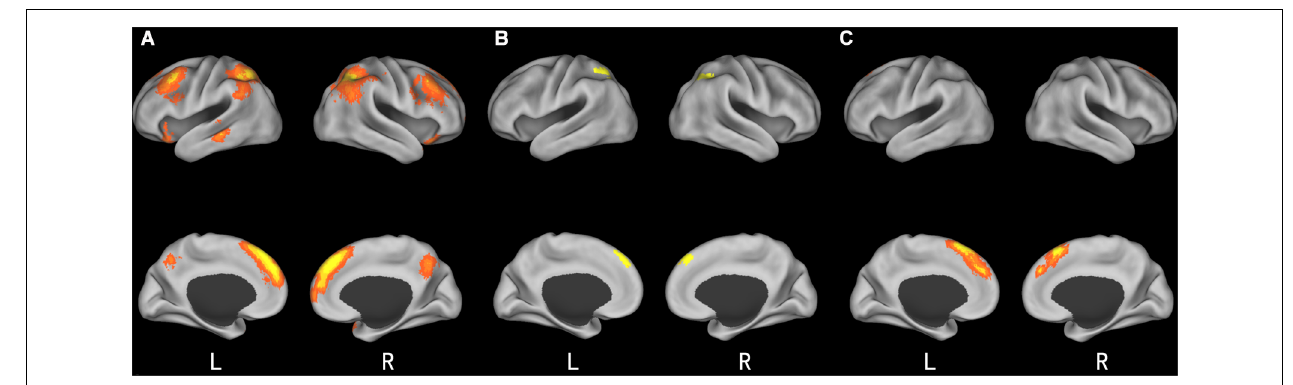
FIGURE 3 | Brain regions involved in social influence. (A) incongruent > baseline; (B) congruent > baseline; (C) incongruent > congruent.